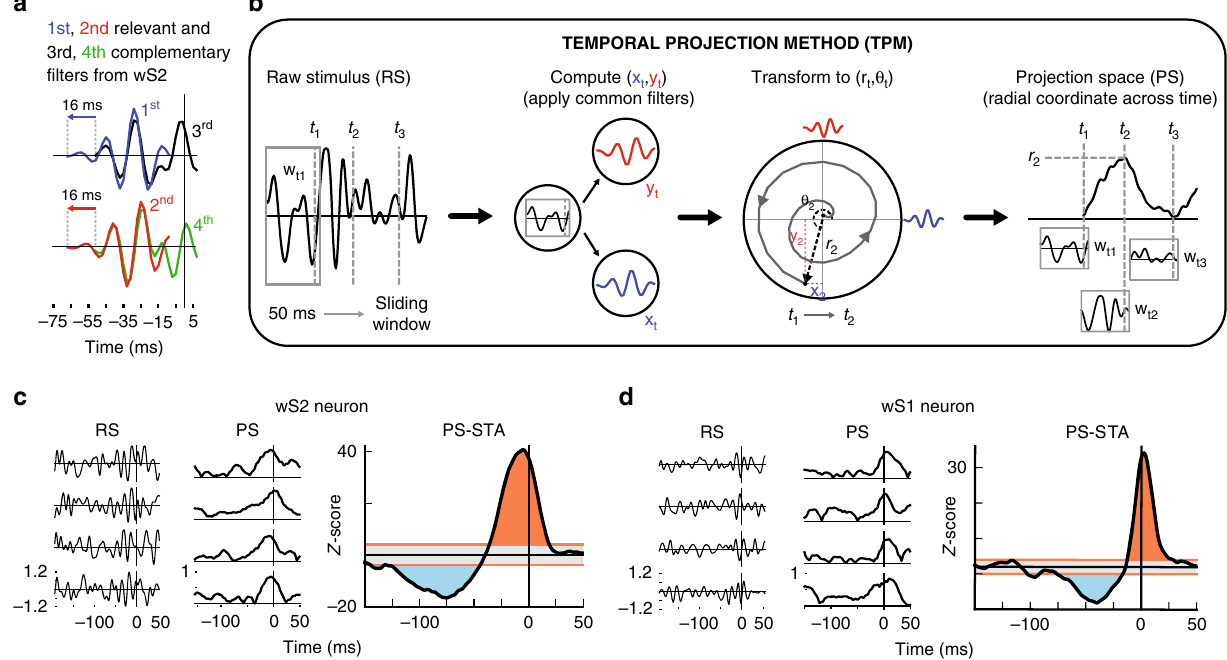
Fig. 3 Temporal projection method (TPM) uncovers distinct temporal dynamics in wS2 and wS1. a Same analysis as in Fig. 1 with an extended window ( − 55 pre- and 5 ms post-spike) for wS2. Shifting the fi rst and second PCs by 16 ms overlays them very well with the third and fourth PCs (See Supplementary Fig. 2). b Change of coordinates from whisker position raw stimulus (RS) to relevant fi lter projection subspace (PS). Left: A 50 ms sliding window is passed over the RS. For each time t , we use − 45 ms pre- 5 ms post, just as the fi lters were generated in Fig. 1. Middle left: Each RS window can be projected into the region-speci fi c phase space resulting in an x-coordinate on the PC1 axis (blue, x t ) and a y-coordinate on PC2 axis (red, y t ). Middle right: As the window slides through time, this creates a trajectory in phase space ((x t , y t ) or (r t , θ t )). Right: The radial coordinate in the phase space across time. PS value represents how strongly the stimulus in the 50 ms window projected into the phase space. c , d Left: four examples of a spike-triggering RS. (195 ms pre- and 55 ms post-spike). Middle: PS trajectory of the same stimulus. Right: PS spike-triggered average (PS-STA) in z -score values (compared to a shuf fl ed stimulus distribution). Gray region represents ± 2 z -score zone outside of which the area under the curve is shaded red for positive area and blue for negative area. c An example wS2 neuron with extended temporal stimulus dependence. d An example wS1 neuron that responds sharply at short